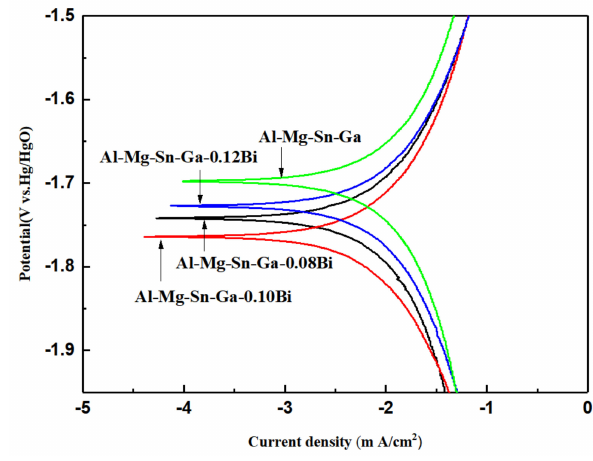
Figure 7. Polarization curves of the Al-Mg-Sn-Ga-xBi alloys. Table 3. Corrosion parameters of the alloys derived from polarization